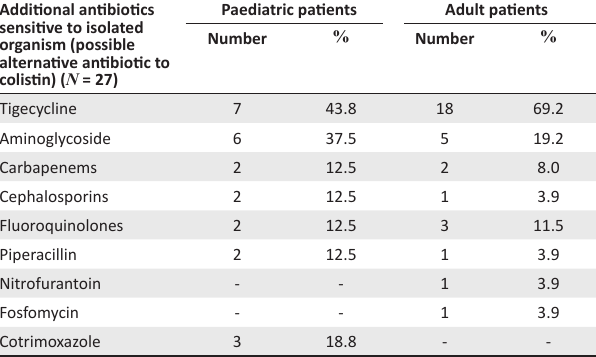
Paediatric patients